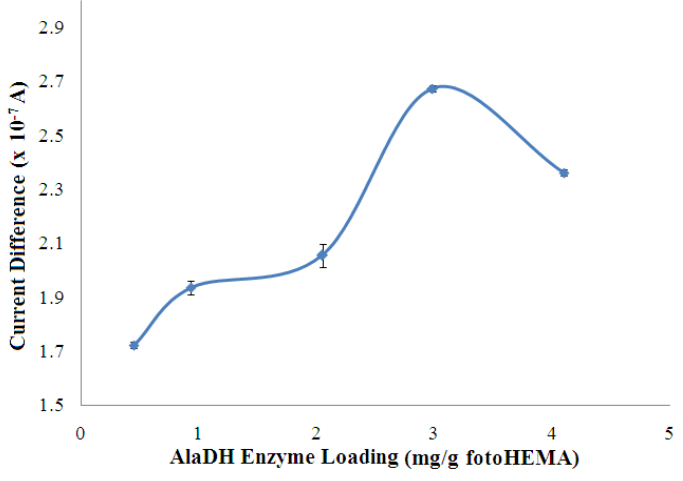
Figure 5. Effect of enzyme loading on biosensor response in a solution containing 100 mM NH 4+ ion at pH 7 (n =